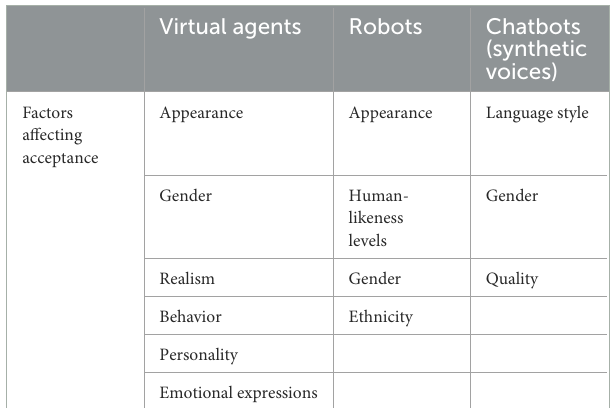
TABLE 1 The main factors affecting acceptance of each interactive